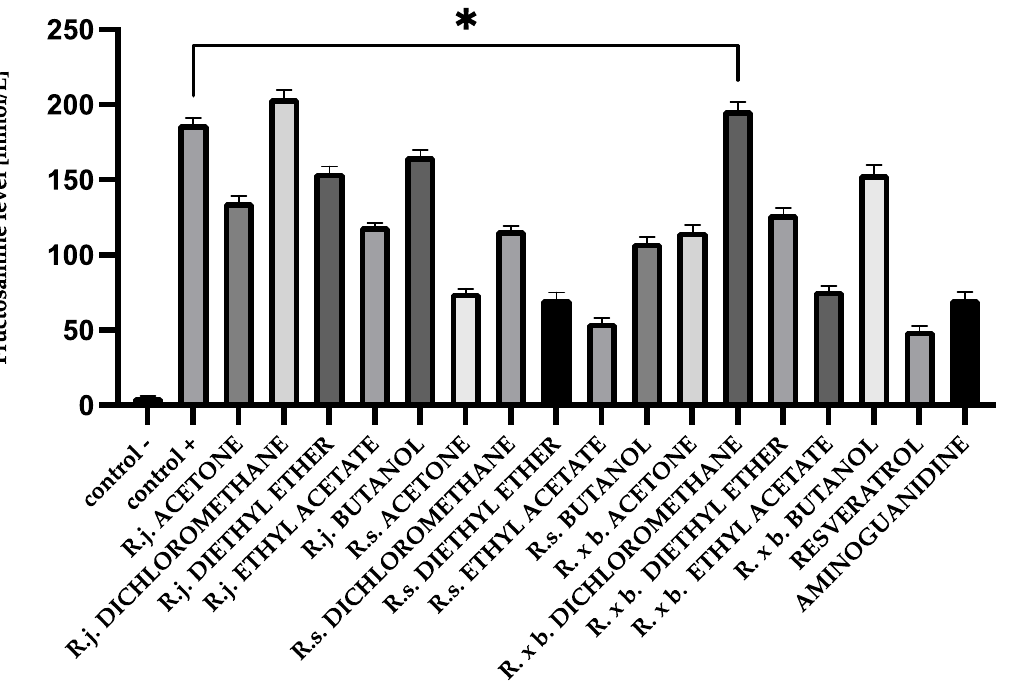
Figure 2. The effect of extracts and fractions on the in vitro formation of fructosamine in BSA glycation. R.j., R.s., and R. × b. mean Reynoutria japonica , Reynoutria sachalinensis , and Reynoutria × bohemica , respectively. Error bars shown in this figure are means ± SD for n ≥ 5. * Statistically significant at p ≤ 0.05 compared to control +. All other results are statistically significant at p ≤ 0.0001 compared to control +. Detailed information can be found in the Supplementary Material.